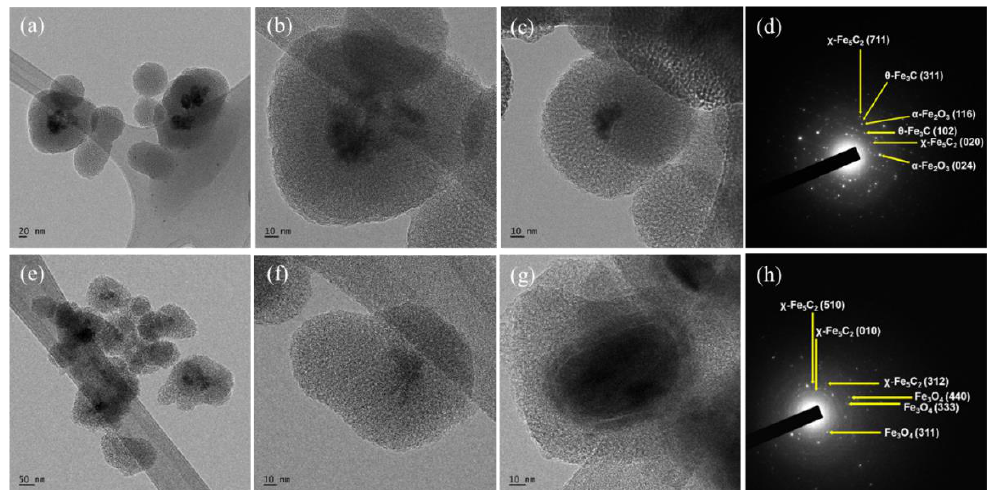
Figure 8. ( a – c ) TEM images and ( d ) SAED pattern of spent χ -Fe 5 C 2 @SiO 2 _L catalyst; and ( e – g ) TEM images and ( h ) SAED pattern of spent χ -Fe 5 C 2 @SiO 2 _H catalyst.